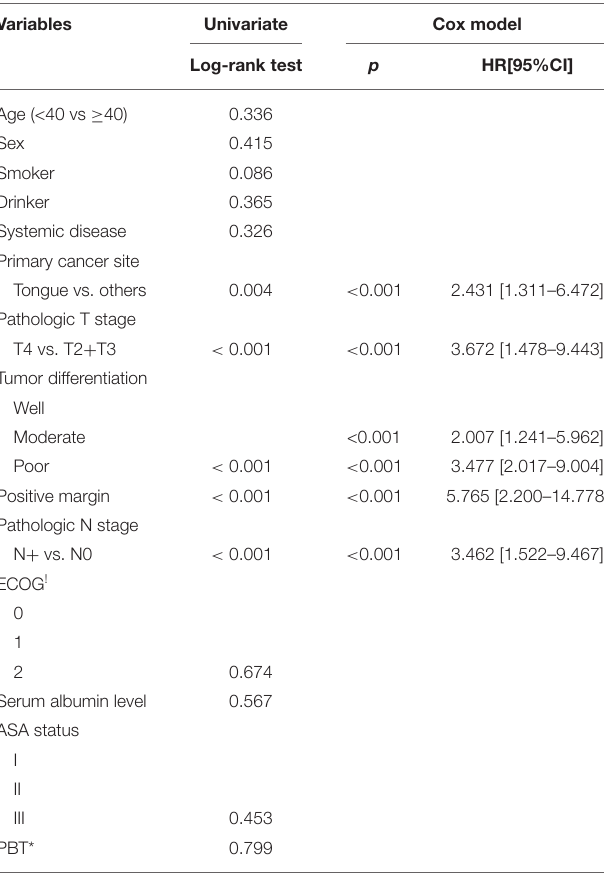
TABLE 4 | Univariate and Cox model analyses of overall survival in the 423 enrolled